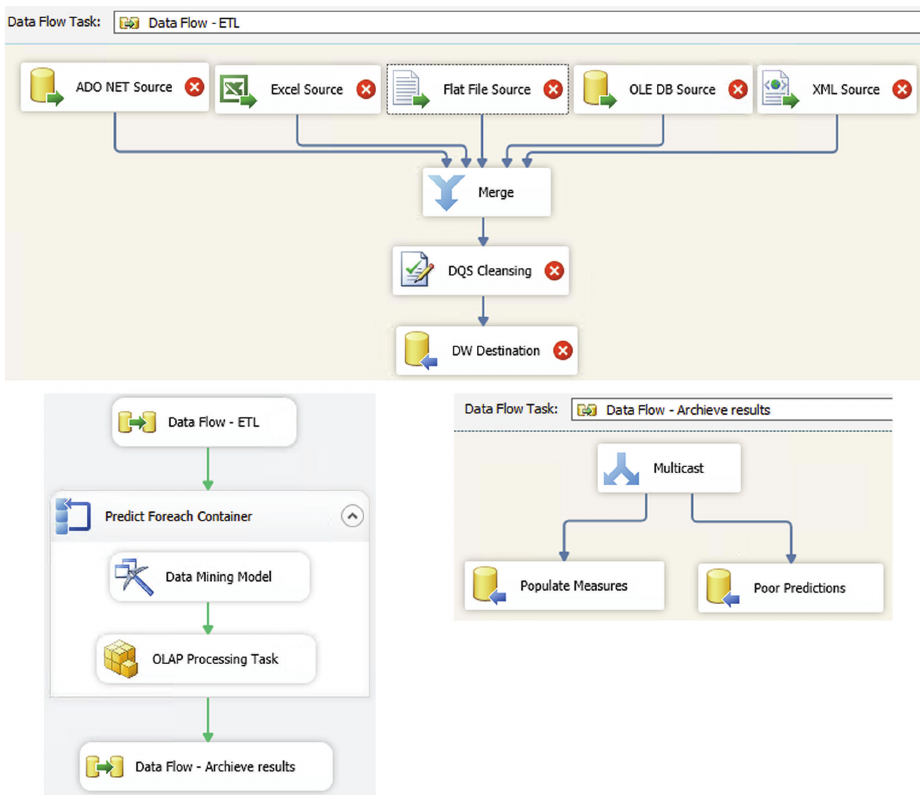
Figure 5: Data mining ETL